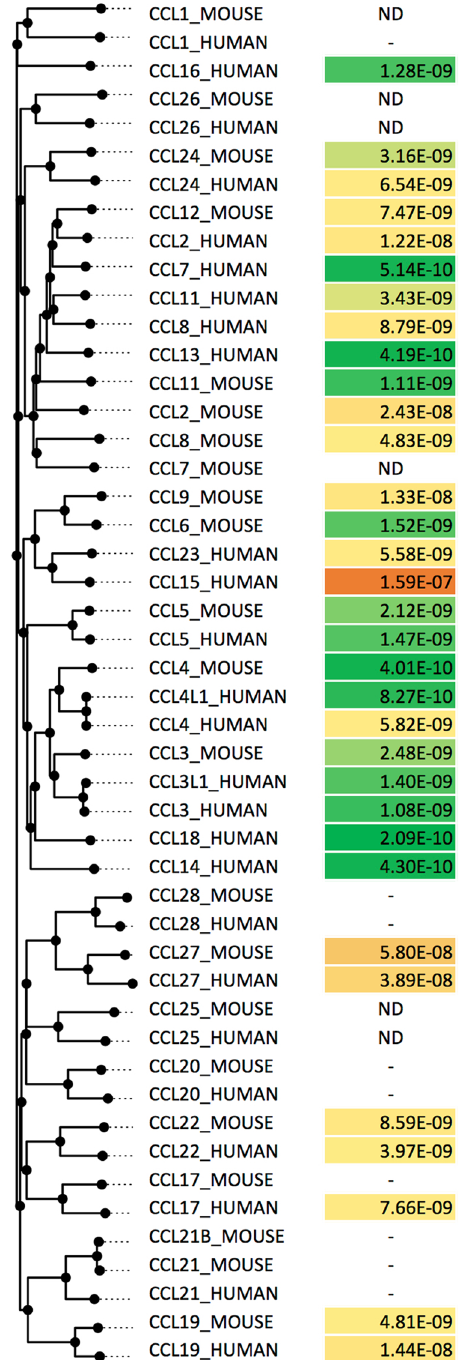
Figure 6. Binding of P991_AMBCA to mouse CC chemokines. Binding affinities ( K d , moles/litre) of P991_AMBCA to mouse CC-chemokines using biolayer interferometry. ND indicates not done. - Indicates that binding was not detected at 300 nM chemokine concentration. Human and mouse CC-chemokines are arranged by sequence-similarity based phylogeny. Human chemokine binding to P991_AMBCA is as shown in Fig. 5, and shown here for comparison to mouse binding data. Higher affinity binding is indicated as shades of green, medium affinity as yellow, and lower affinity as shades of